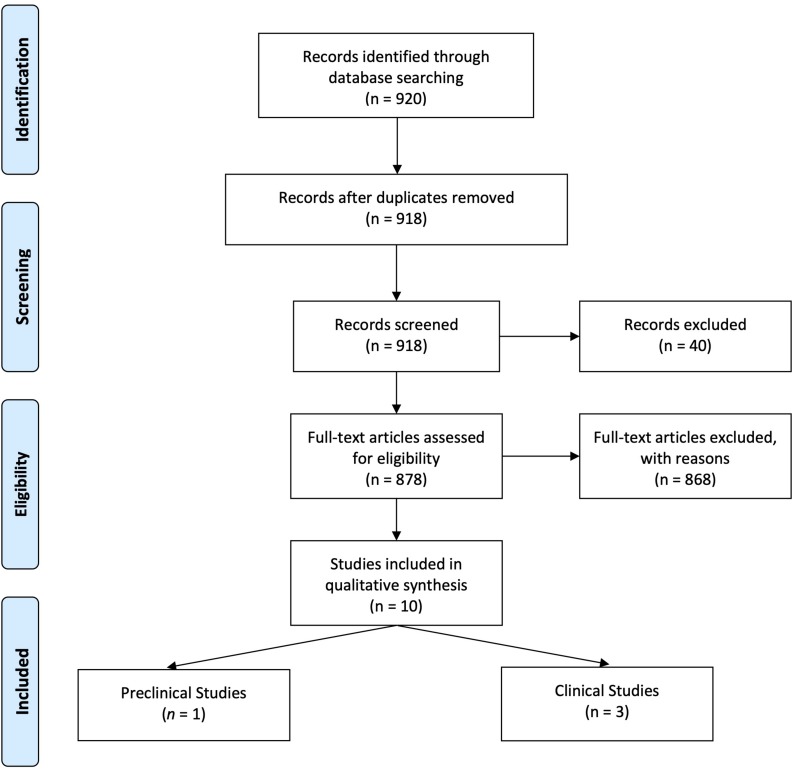
PRISMA Flow Diagram.